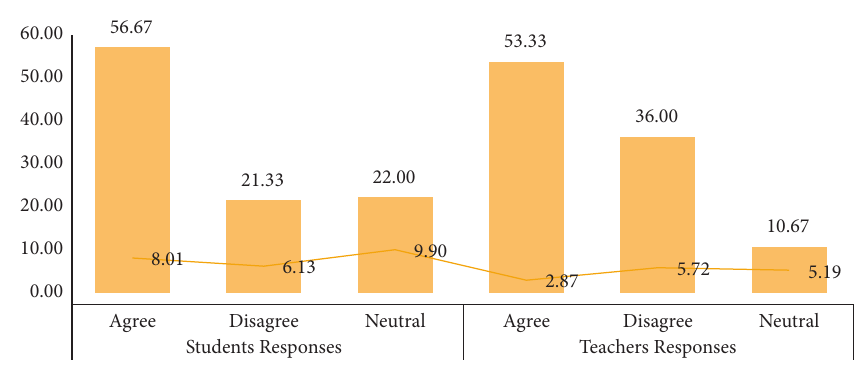
Figure 1: Summary of teacher factor aspect.